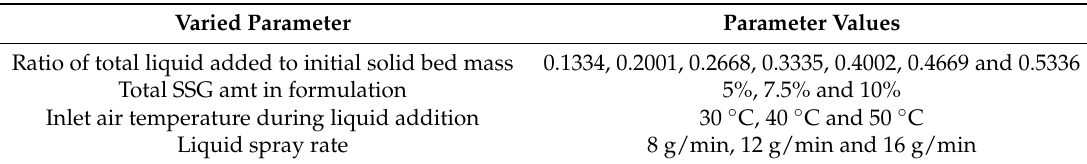
Table 4. The DOE settings for other modeled FBG cases at 1 bar nozzle atomization